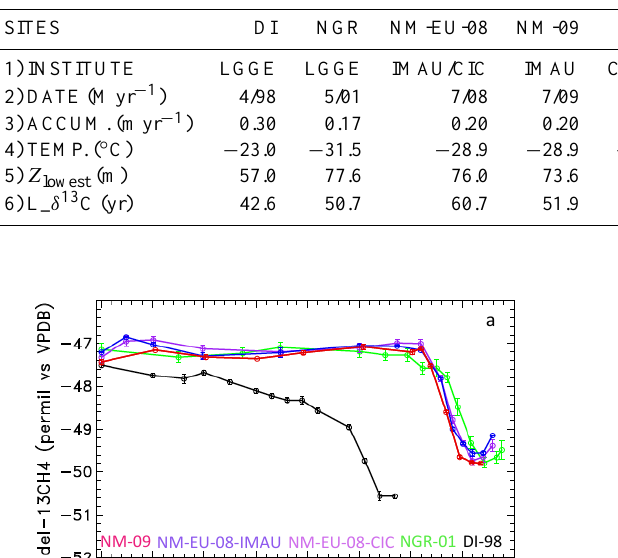
ment with direct atmospheric measurements (Levin et